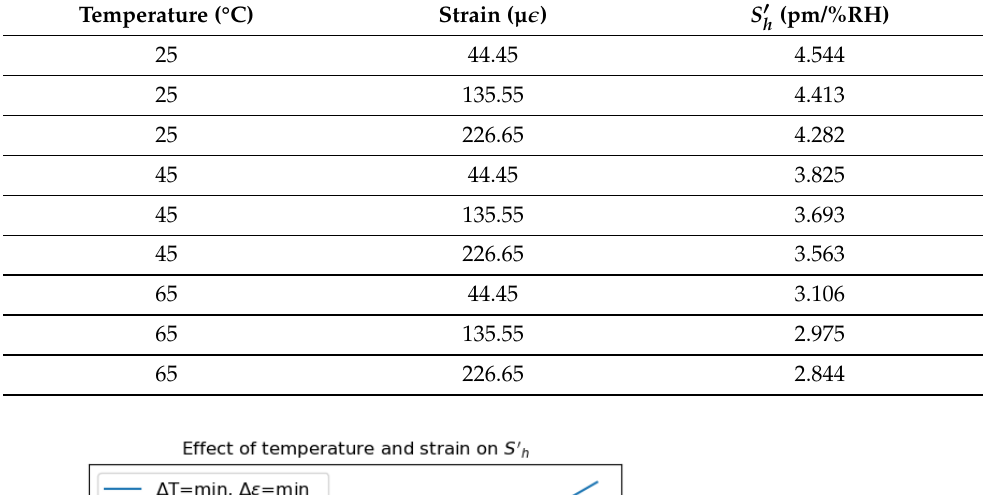
Table 11. Humidity sensitivity for different temperature and strain conditions.